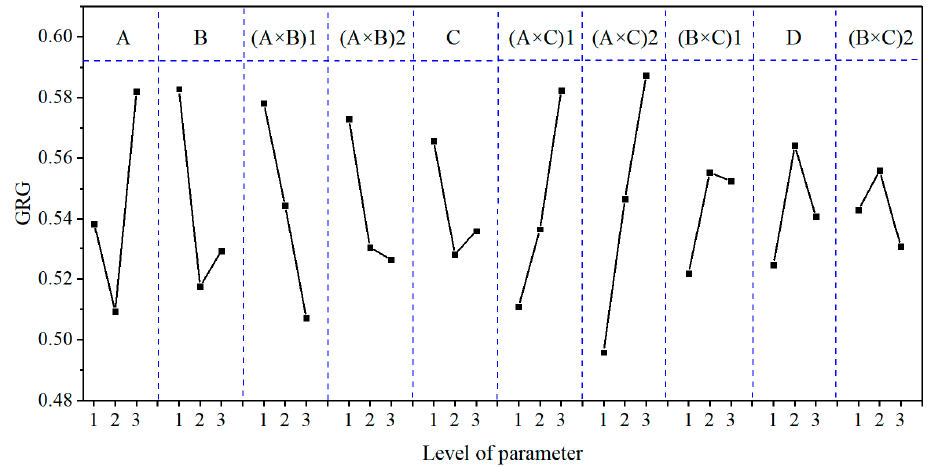
Figure 8. The effect plot for GRG.